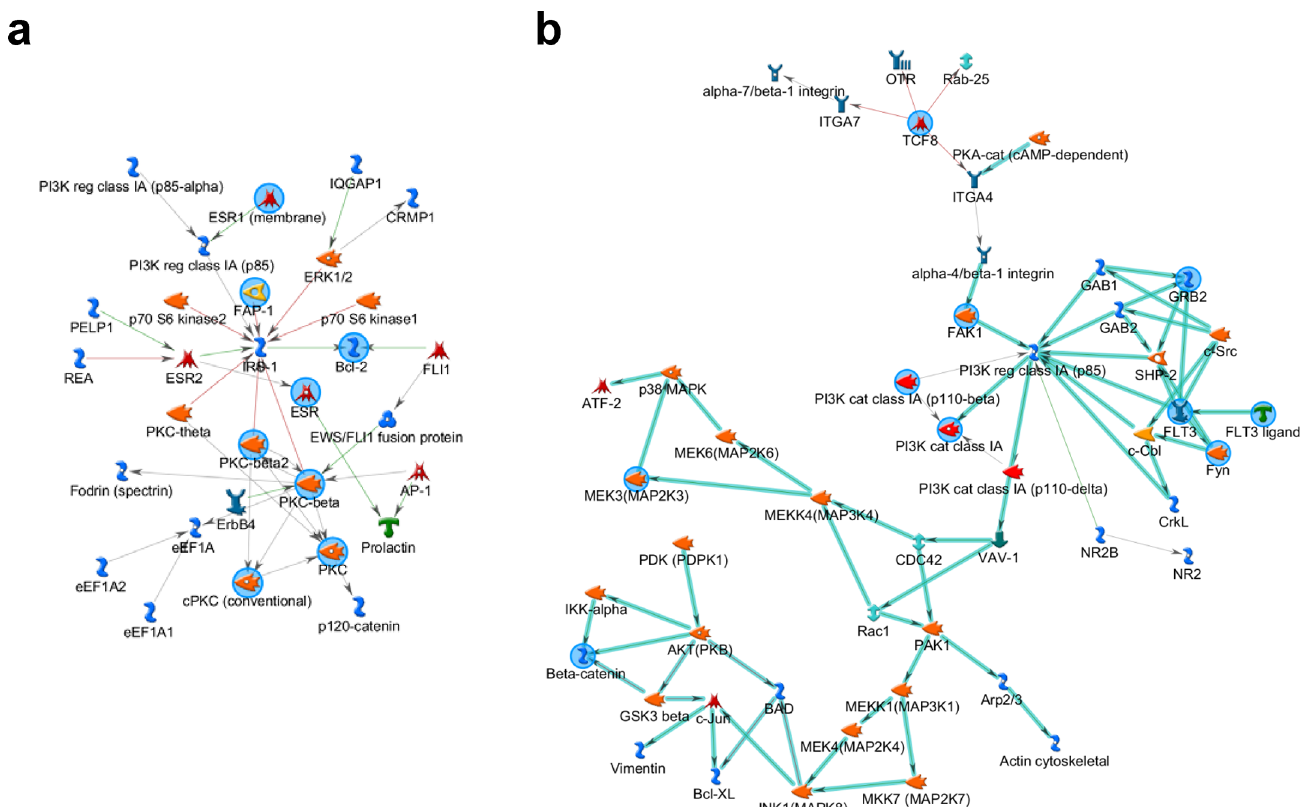
Fig 5. The functional network of top inflammation-related genes created by integrative analysis of mRNA expression associated with aberrant DNA methylation (a) and SCNA (b) in HBV-related HCCs. Blue circles represent the key nodes of the network.